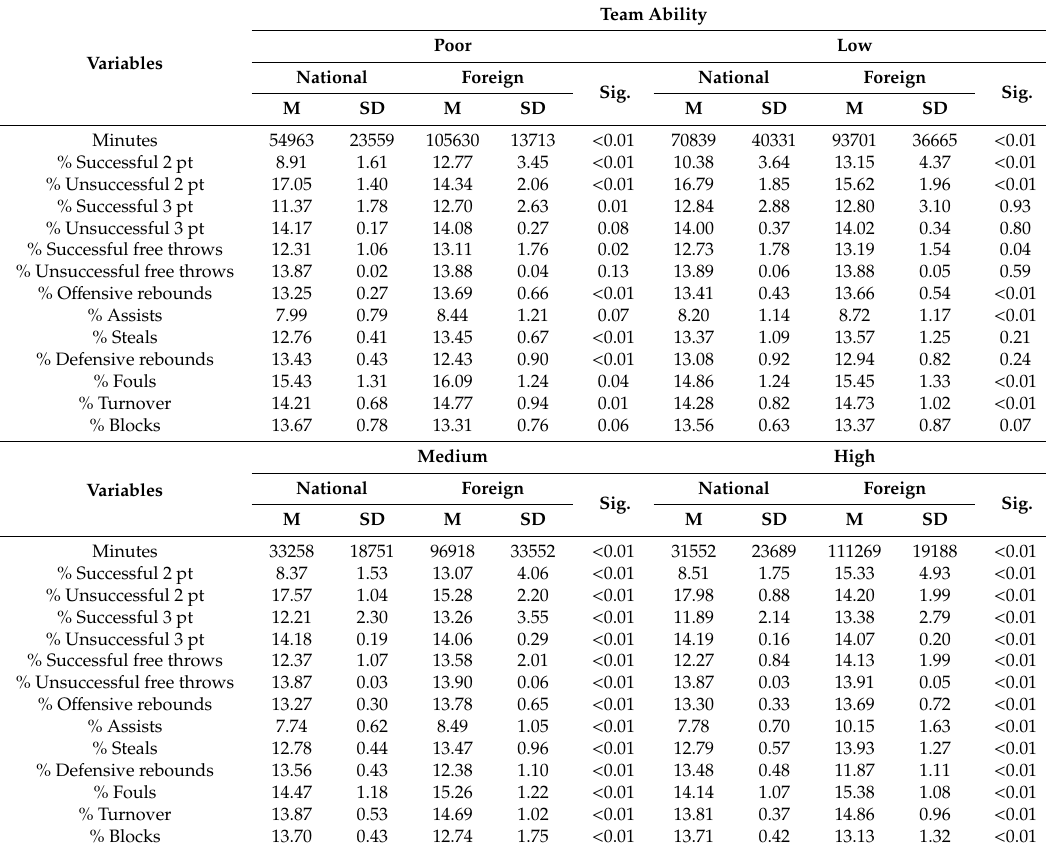
Table 2. Descriptive results (M, mean; SD, standard deviation) of national and foreign Forwards based upon poor, low, medium, and high team